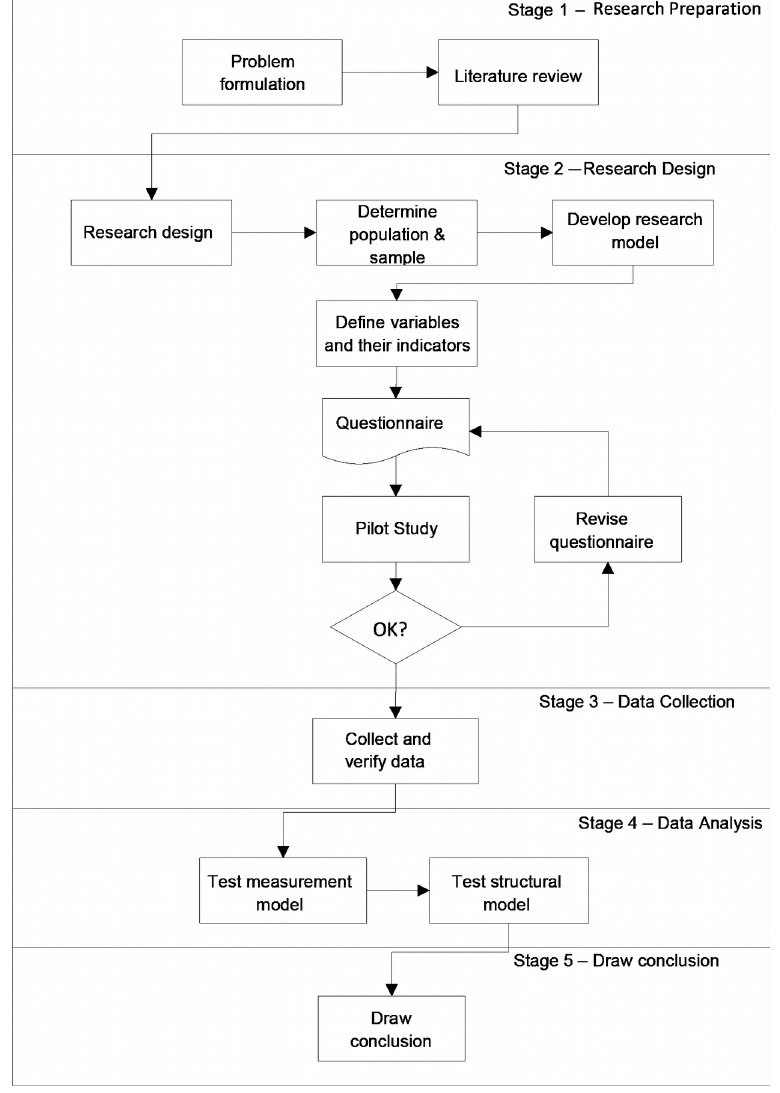
Figure 3. Research